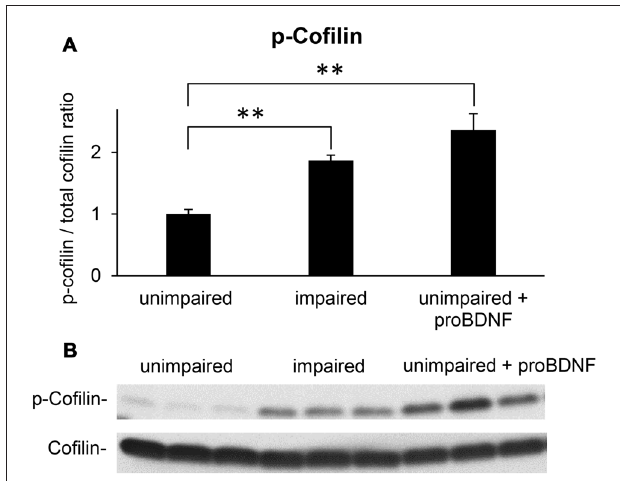
FIGURE 4 | Intra-hippocampal infusion of proBDNF increases p-cofilin levels in memory-unimpaired mice to levels seen in memory-impaired mice. (A) p-Cofilin to total cofilin ratio in memory-unimpaired mice, memory-impaired mice, and memory-unimpaired mice infused with proBDNF. (B) Representative p-cofilin and cofilin blots. ∗∗ p <